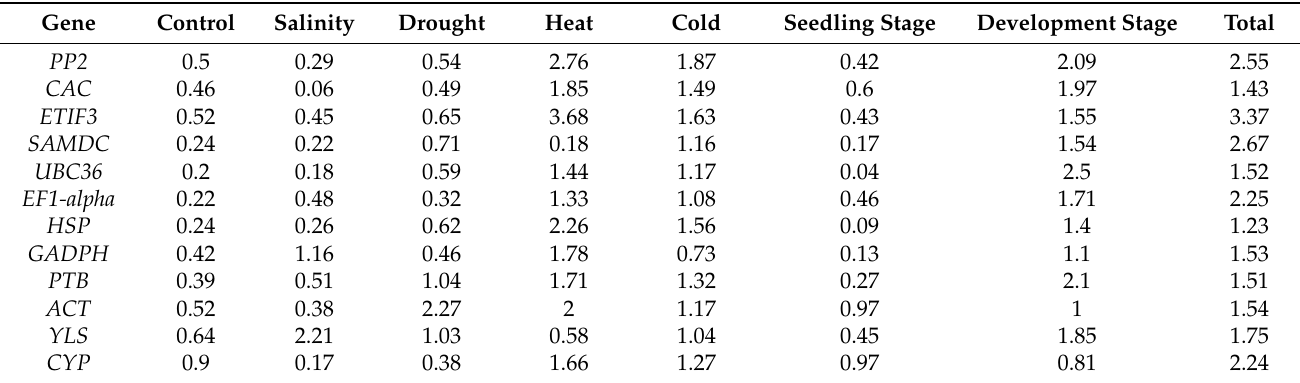
Table 2. Reference genes expression stability ranked by BestKeeper under different abiotic stresses and at developmental stages in Ae. tauschii